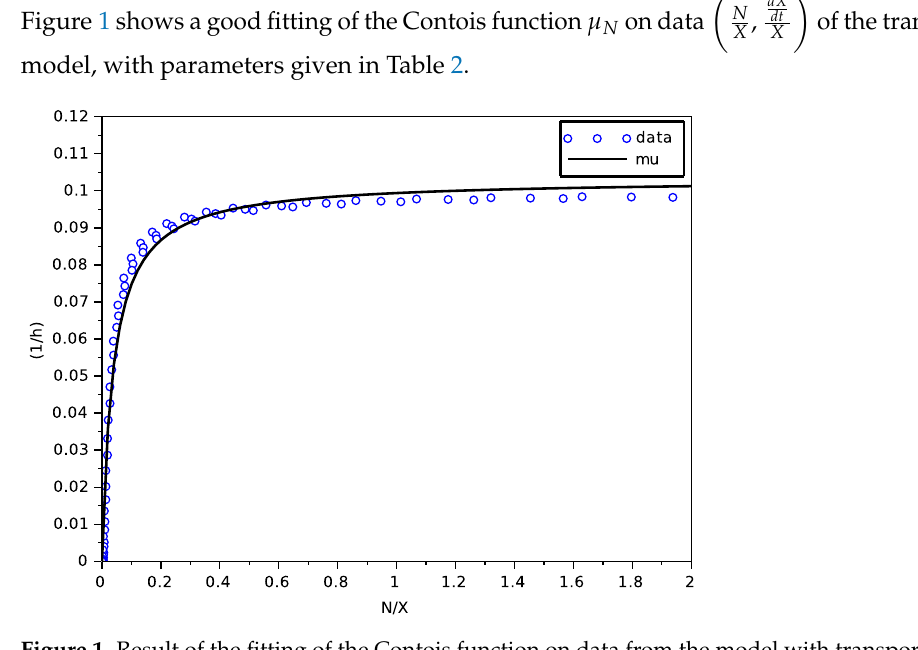
Figure 1. Result of the fitting of the Contois function on data from the model with transporters. Table 2. Parameters of the Contois function µ N